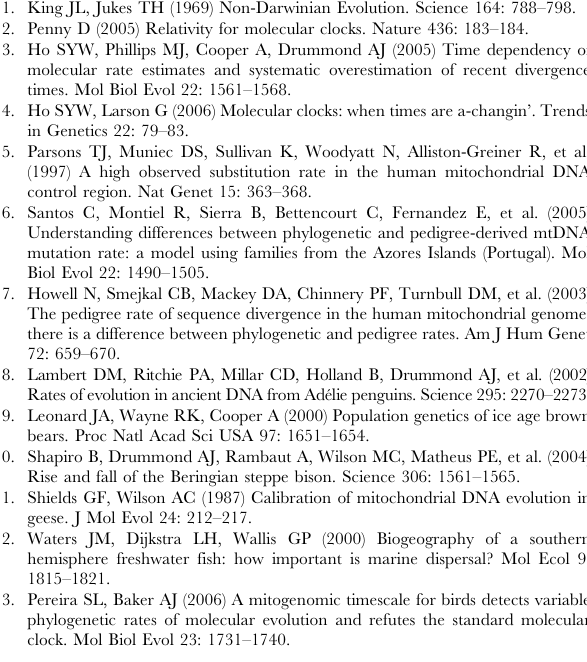
Table S2 Discrimination of heteroplasmic bases from back- ground noise.